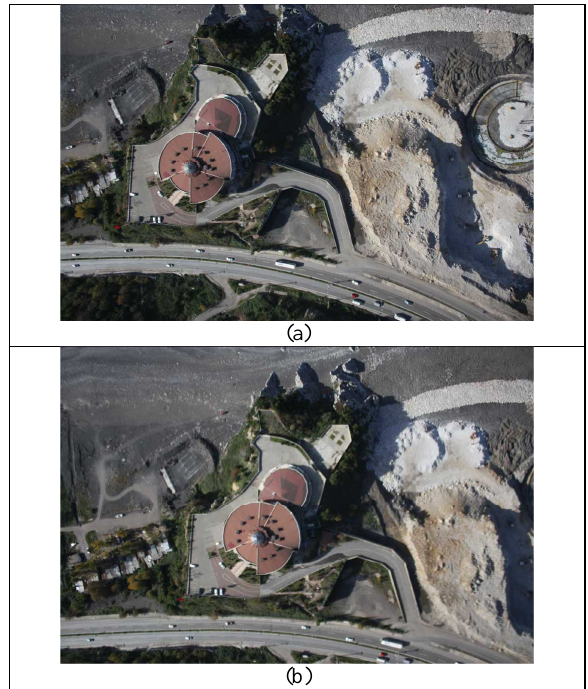
Figure 9 Stereo Pair Used for Application Good distributed GCPs and parallax points have been chosen for evaluation and shown on left image in Figure 10. Both derived ortho-image and 1/1000 scaled topographic maps can be seen as overlapped in Figure 11.